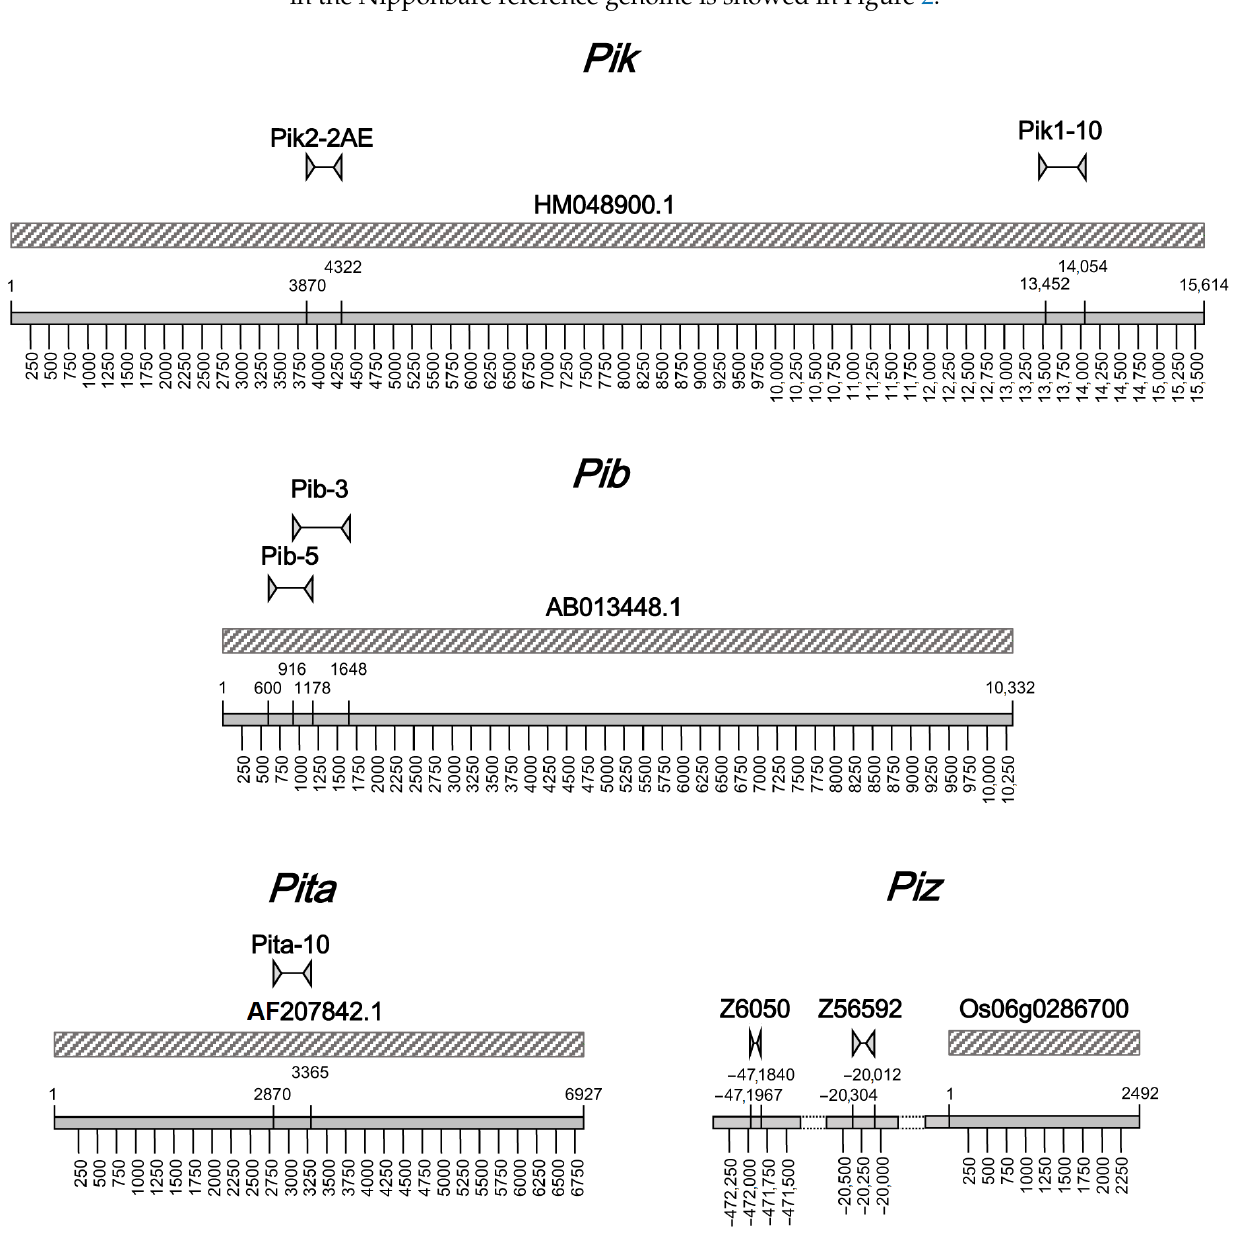
Figure 2. Position of the Pi markers listed in Tables 1 and 2 in the Pik , Pib , Pita , and Piz homolog genes on Nipponbare reference genome IRGSP-1.0 (GenBank accessions HM048900.1 (LOC_Os11g46210, Os11g0689100), AB013448.1 (LOC_Os02g57305, Os02g0818450), AF207842.1 (LOC_Os12g18360, Os12g0281300), and RAP-DB accession Os06g0286700 (LOC_Os06g17900),